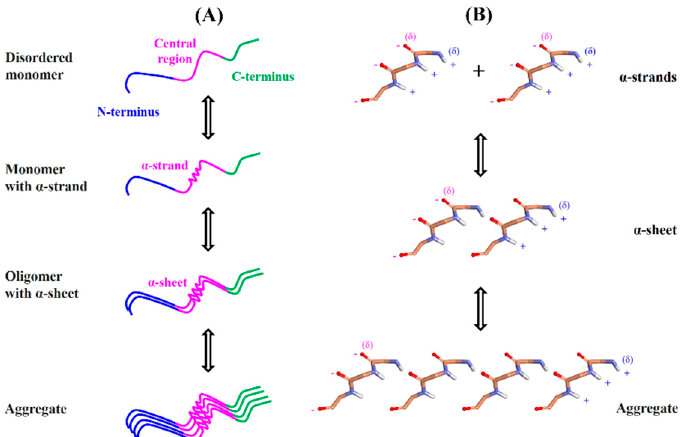
Figure 5. Proposed aggregation mechanism. ( A ) Schematic representation showing α -strand/ α -sheet formation during A β 1–42 aggregation process. N-terminal, central region, and C-terminal are indicated by blue, pink, and green colors, respectively. Central region (residues 24–26) of the monomer adopts the α -strand conformation occasionally. Hydrogen bonding between the α -strands leads to the formation of α -sheet structure in the oligomers. The α -sheet structure acts as a nucleus that initiates the aggregation process. Elongation of nucleus through the incorporation of further A β 1–42 molecules form a mature fibril. ( B ) Alignment of carbonyl and amino groups generates two complementarily charged interfaces in the α -sheet structure. Attractive forces between the interfaces with opposite charges facilitate the aggregation of A β 1–42 . Negative and positive partial charges on the interface are shown by red and blue colors, respectively.